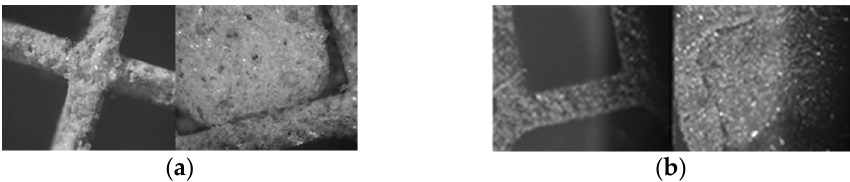
Figure 1. Optical microscopy images of the inner and external piece of ( a ) c-DPF ( b ) DPF.